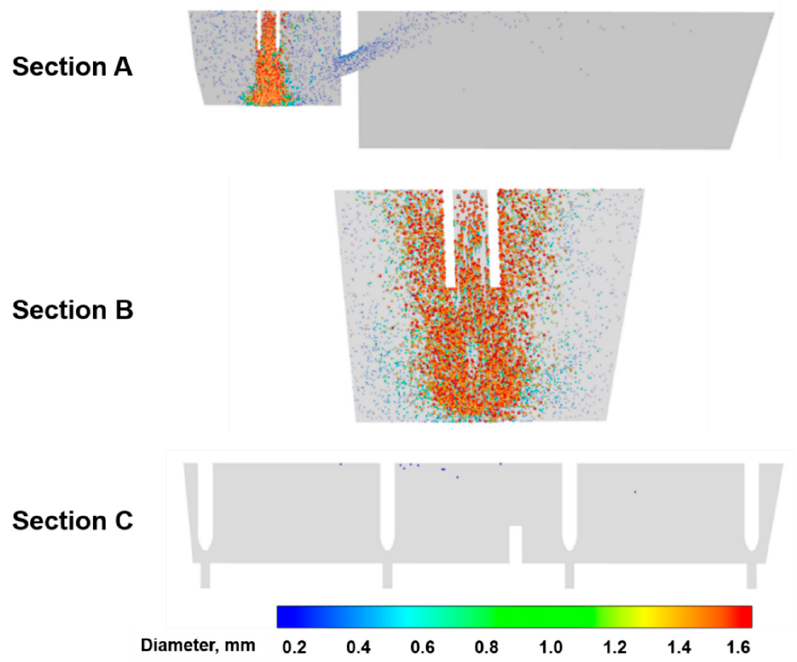
Figure 12. Distribution of bubbles at the three characteristic cross-sections.